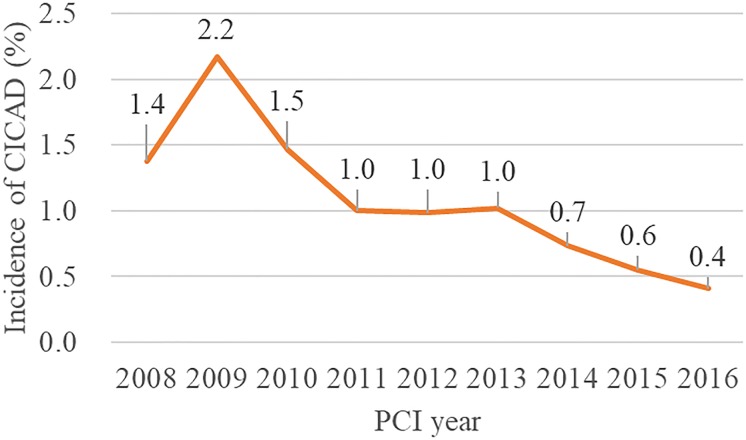
Annual incidence of catheter-induced coronary artery dissection.The annual incidence of CICAD was gradually decreasing in study period (p < 0.001 for trend with Cochran-Armitage test). CICAD = catheter-induced coronary artery dissection; PCI = percutaneous coronary intervention.